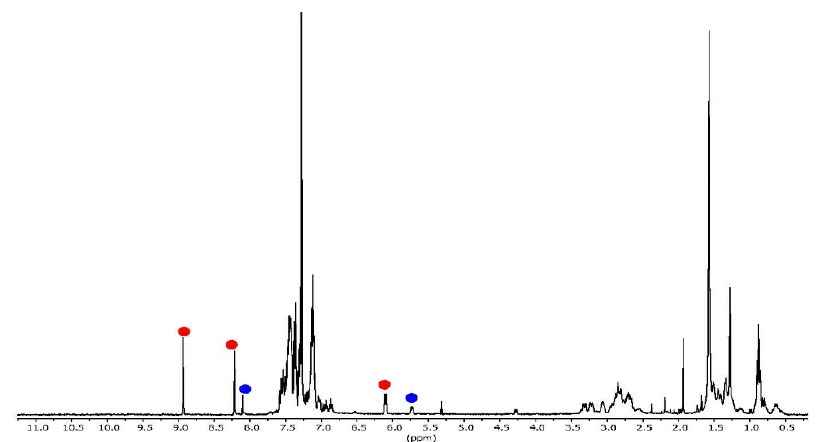
Figure 3. 1 H NMR plot for the 2a → 10 shift at r.t. at room temperature. Compound 2a , red circles; compound 10 , blue circles.